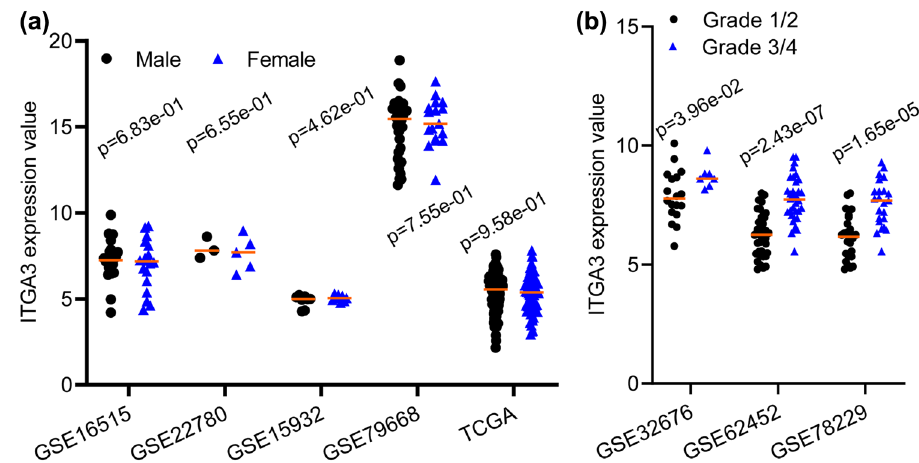
Figure 2: Gene expression pro fi le of ITGA3 in PCa tumor tissues. ( a and b ) The di ff erence of ITGA3 in PCa tumor tissues collected from male or female patients, or tumor tissues with early or advanced grade, respectively. The di ff erences between groups were analyzed using the Mann – Whitney U test. The expression levels of ITGA3 are expressed by RMA - normalized expression signal intensity ( log2 values; GSE16515, GSE32676, GSE62452, GSE22780, and GSE78229 ) log2 ( Count + 1 ) ( GSE79668 ) , VSN - normalized signal intensity ( log2 values; GSE15932 ) , or log2 ( fragments per kilobase of exon per million fragments mapped, FPKM ) ( TCGA )